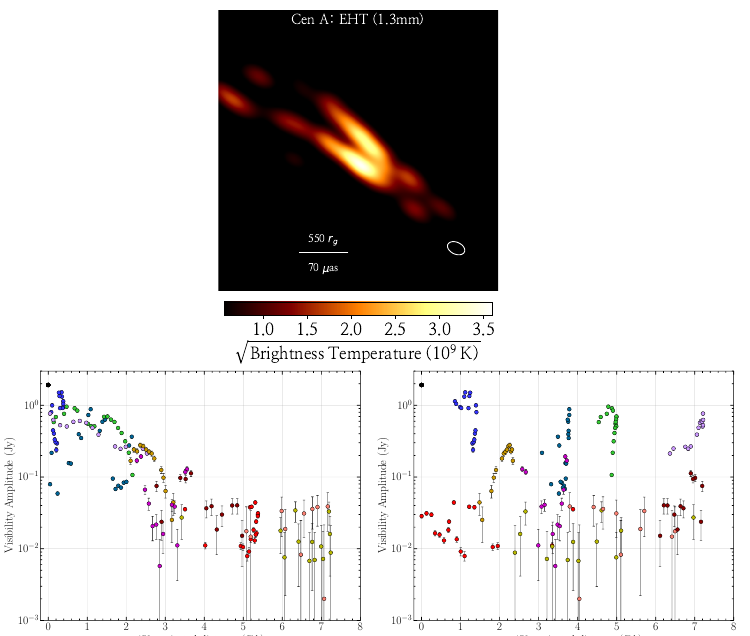
Figure 5. VLBI image reconstruction and underlying visibility amplitude data reproduced from Janssen et al. [114]. The results are from EHT observations of Centaurus A in 2017 at 228GHz. The image shown in the left panel was reconstructed with the eht-imaging regularized maximum- likelihood method. The right panel shows the visibility amplitudes as a function of ( u , v ) -distance projected along the jet direction ( top ) and perpendicular ( bottom ) to the jet